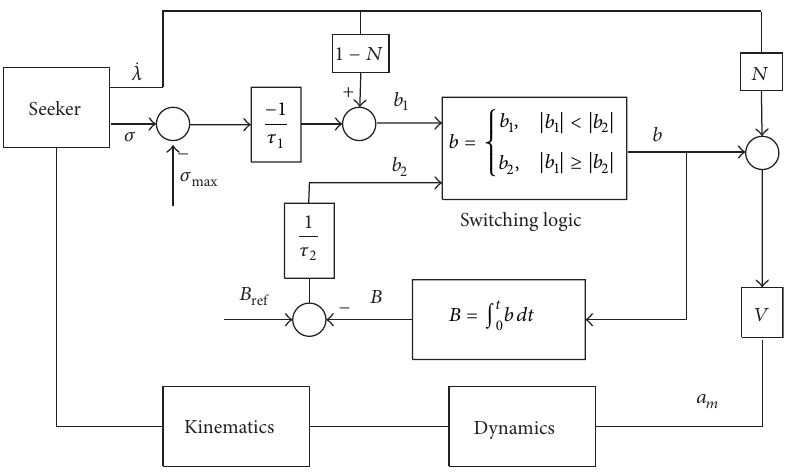
Figure 2: TVBPN guidance